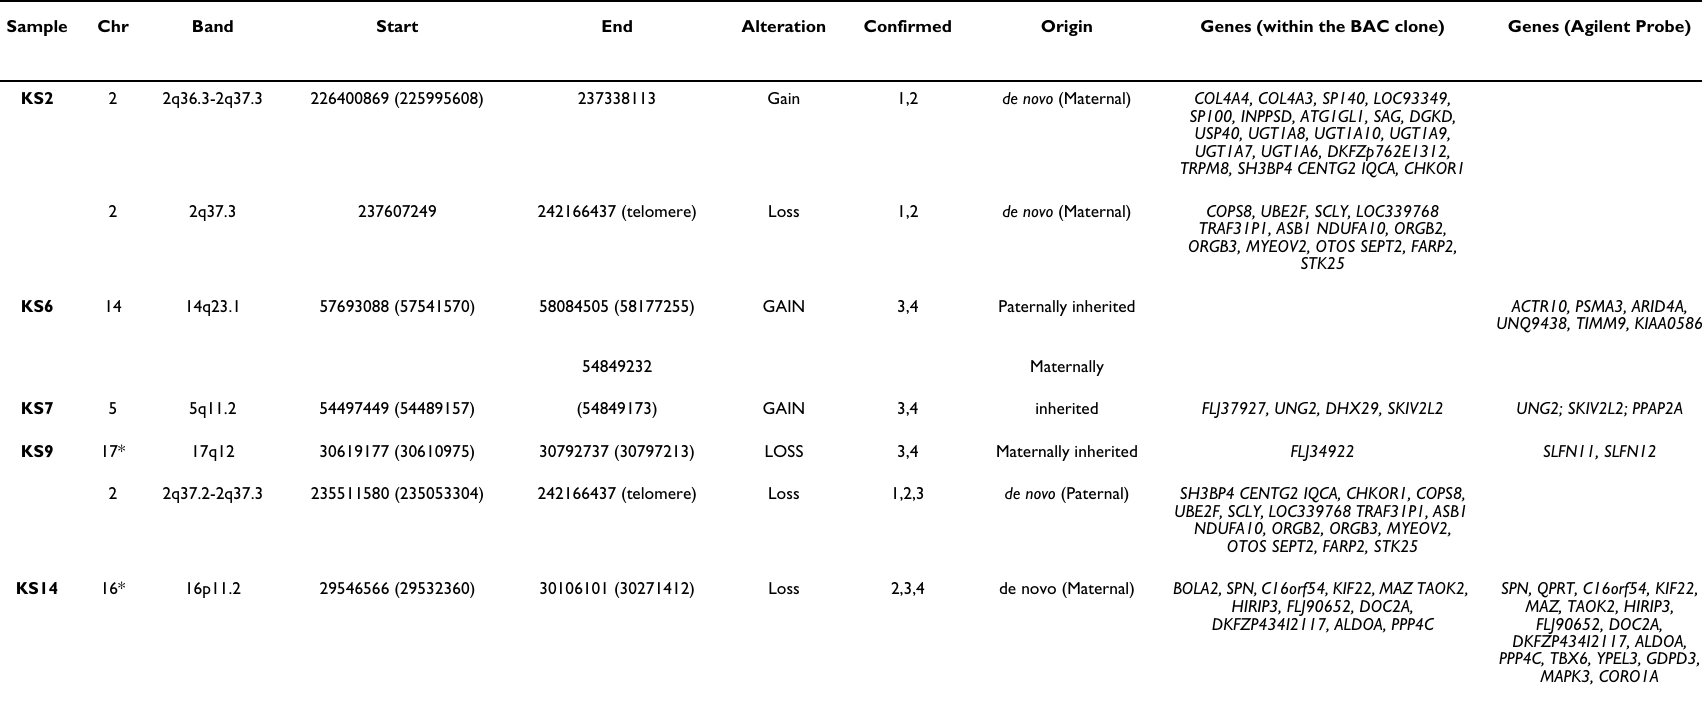
Table 2: Patient specific rearrangements detected by aCGH